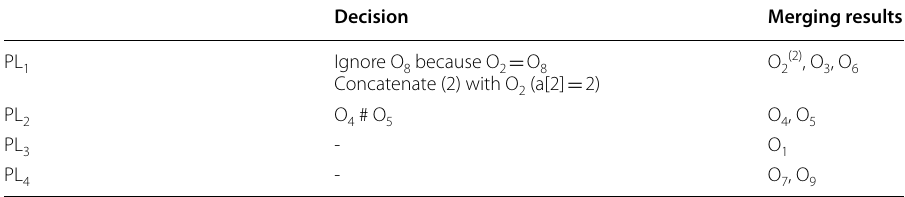
Table 5 The result of merging the same OSs in each priority